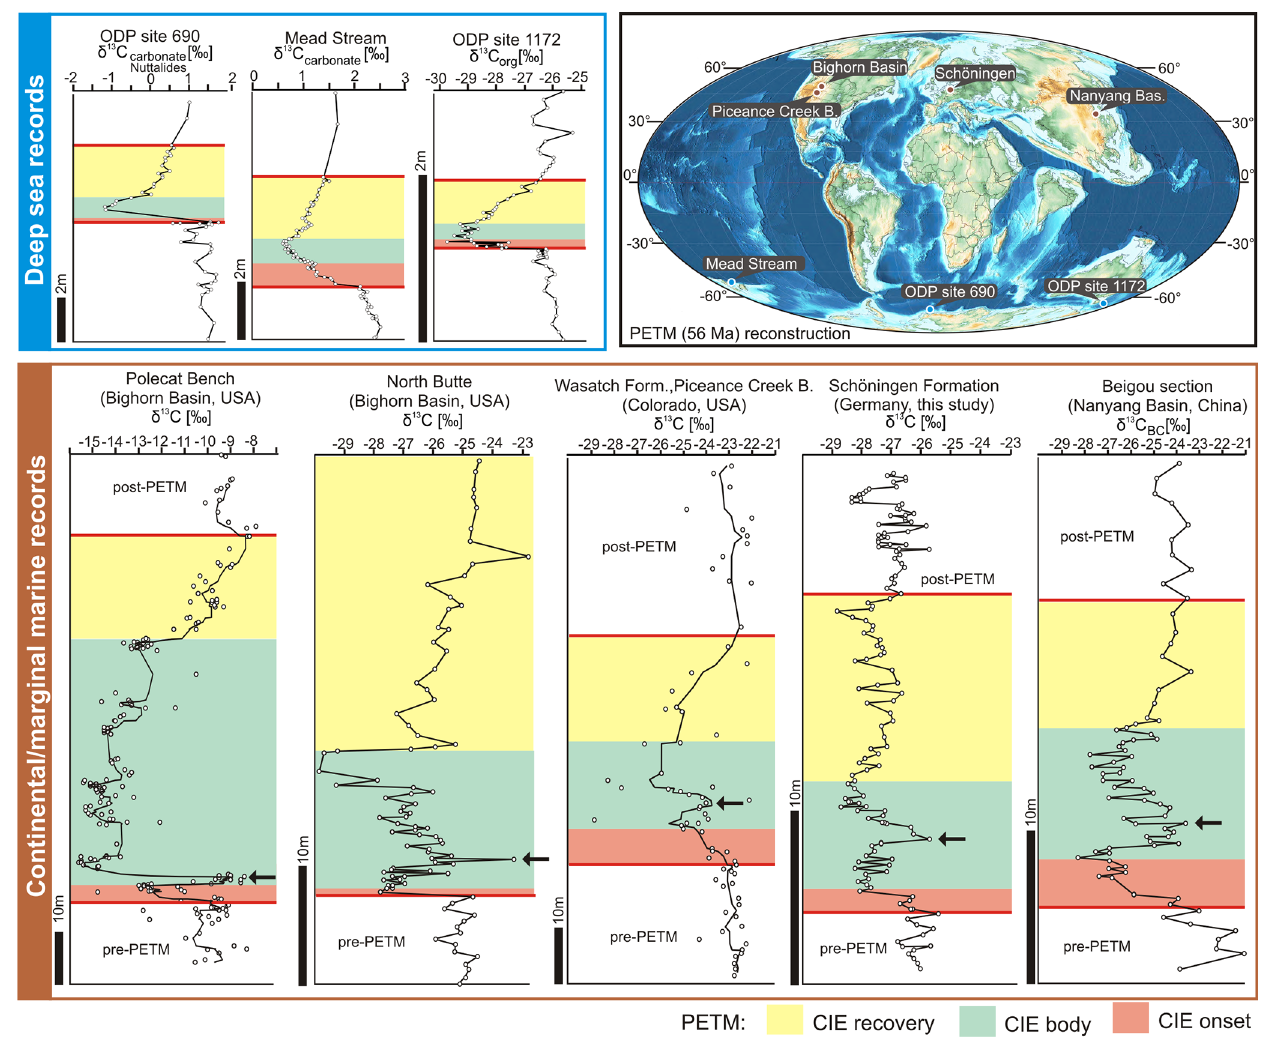
Figure 6. Comparison of typical δ 13 C records for the Paleocene–Eocene Thermal Maximum (PETM) in deep-sea and continental to marginal marine records indicating that non-marine records commonly show a rebound to higher δ 13 C values during the CIE body (black arrows). Data for the marine records: ODP Site 690, Maud Rise, South Atlantic (Nunes and Norris, 2006); Mead Stream, New Zealand, South Pacific (Nicolo et al., 2010); ODP Site 1172, East Tasman Plateau, Tasman Sea (Sluijs et al., 2011). Data for continental and marginal marine records: Polecat Bench, Bighorn Basin, USA (Bowen et al., 2015) – the black line corresponds to a five-point running mean of data; North Butte, Bighorn Basin, USA (Baczynski et al., 2013); Wasatch Formation, Piceance Creek Basin, USA (Foreman et al., 2012) – the black line corresponds to a five-point running mean of data; Beigou section, Nanyang Basin, central China (Chen et al., 2014; in contrast to standard measurements of δ 13 C – bulk organic matter – not only carbonates were removed from the samples prior to δ 13 C BC measurements, but also silicates by using hydrofluoric acid). Locations of the study sites are presented on a continental reconstruction for the PETM (PALEOMAP project, Map 14; Scotese, 2014). An extension of the figure is added as Fig. S5 in the